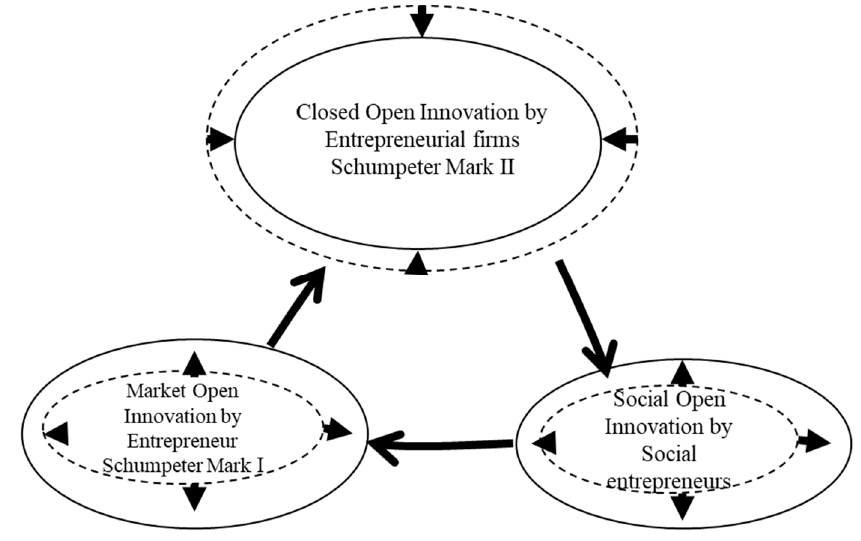
ff ect of reflective basic innovation on open innovation Figure 4. The effect of reflective basic innovation on open innovation dynamics. Figure 4. The e